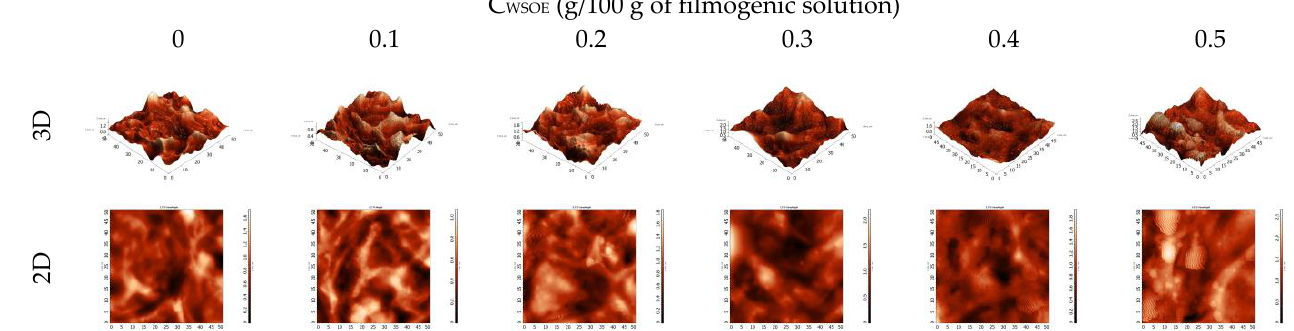
Figure 2. AFM images of films based on cross-linked starch as a function of the incorporation with different concentrations of watermelon seed oil emulsions (C WSOE , g/100 g of filmogenic solution). Table 1. Effect on the average roughness ( 𝑅 𝑎 ) and the roughness mean square ( 𝑅 𝑞 ) of cross-linked cassava starch-based films with different concentrations of watermelon seed oil emulsions (C WSOE , g/100 g of film-forming solution). C WSOE